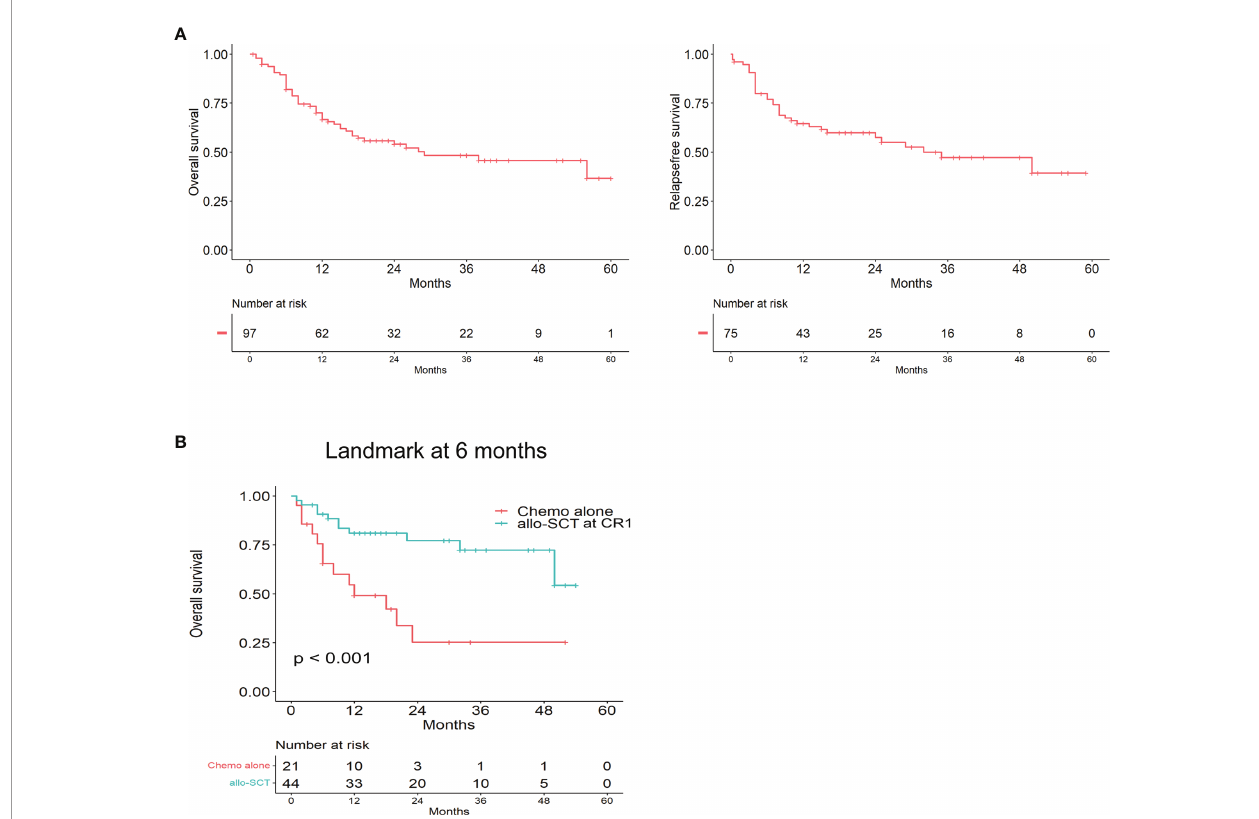
FIGURE 2 | The prognosis of Early T-cell precursor leukemia/lymphoma. (A) Kaplan – Meier analyses for Overall survival and Relapse free survival in the whole cohort. (B) Overall survival for allo-SCT at CR1 and Chemo alone by landmark analysis, with landmark time at 6